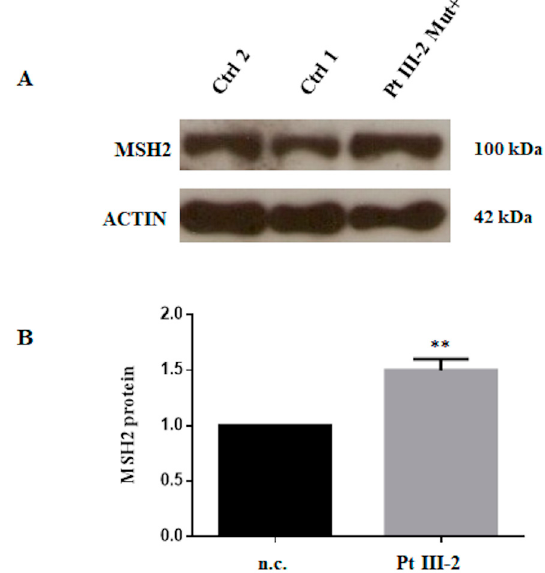
Figure 4. Patient protein analysis. ( A ) Western blot assay of MSH2 performed on protein extracts from peripheral blood cells of index-patient III-2 compared to two normal controls. Actin was used as internal positive reference. ( B ) Histogram showing density of MSH2 protein normalized versus actin protein and compared to the mean of two negative controls, controls 1 and 2 (n.c.). Density of the electrophoretic bands was obtained with ImageJ software. Data represent three independent experiments (mean ±